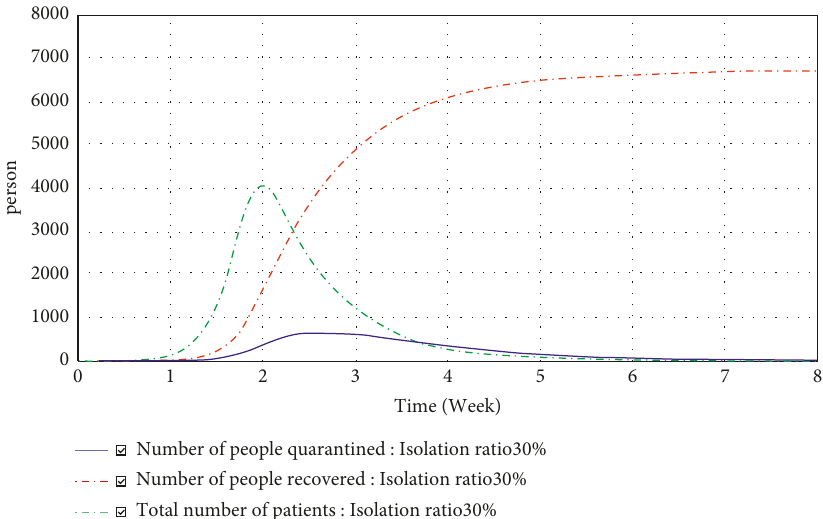
Figure 8: Simulation results of an infection evolving in the third stage.